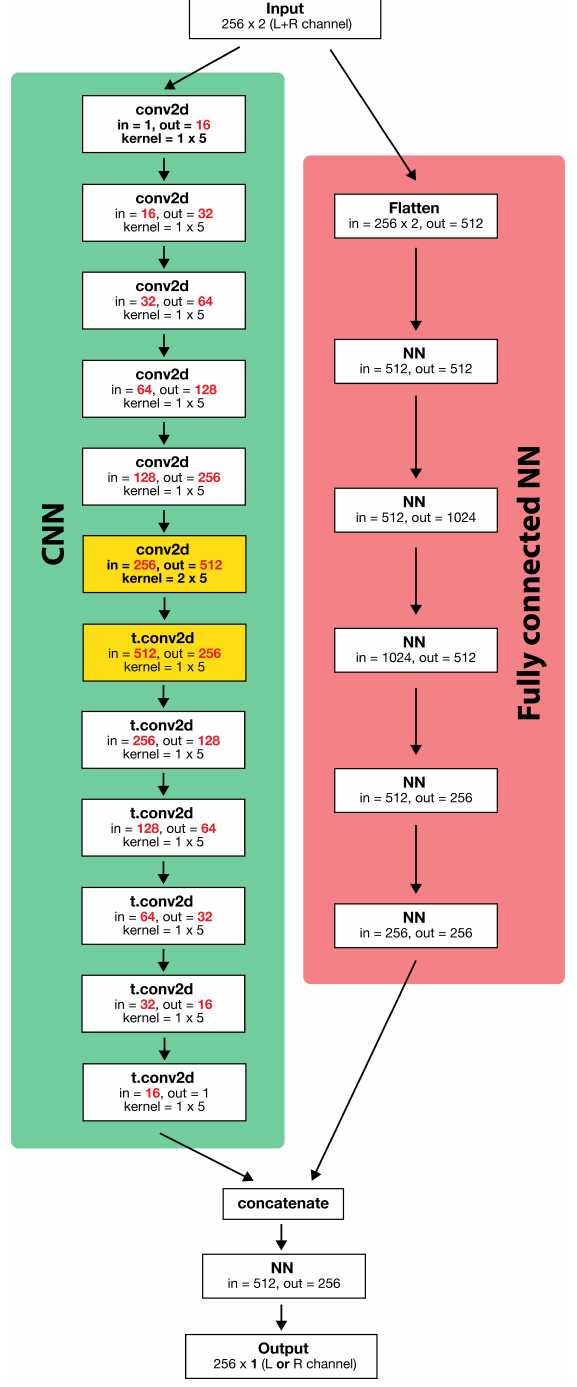
Figure 11. Wider and deeper model (highlighted: the main difference compared to the proposed